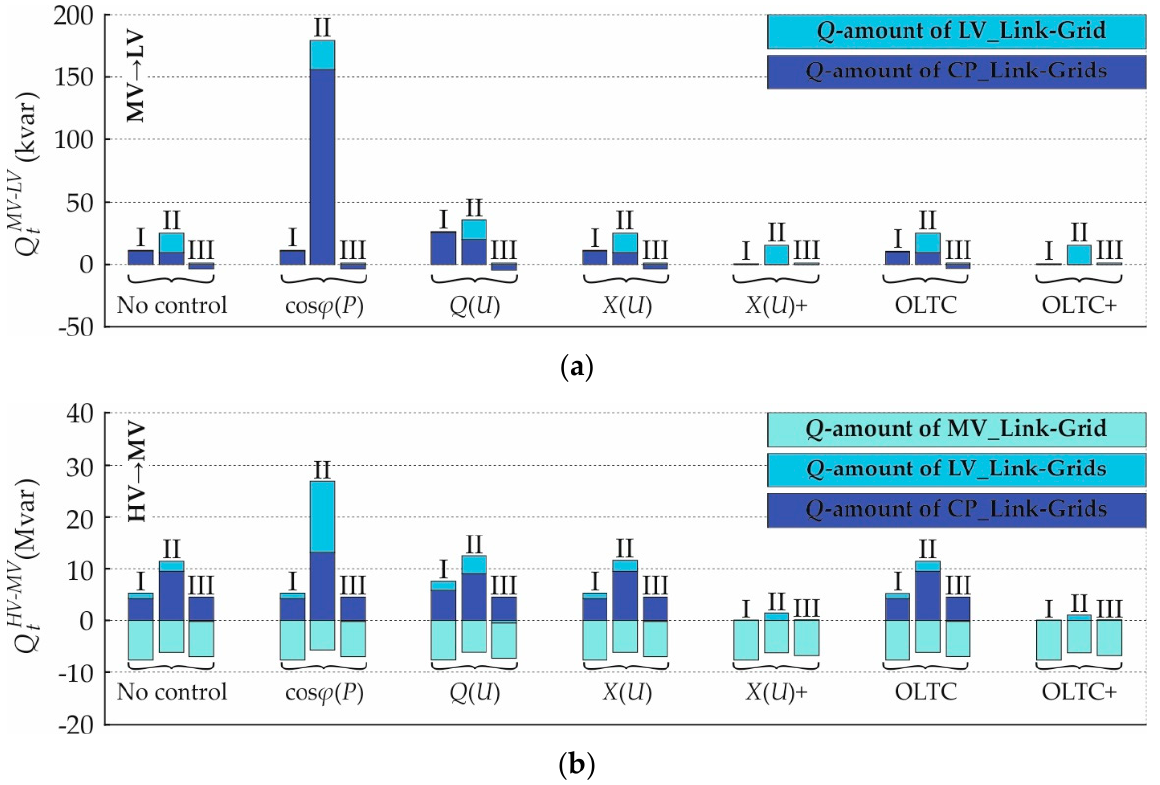
Figure 24. Composition of the reactive power exchange for various control strategies and cases in different system boundaries: ( a ) MV − LV; ( b ) HV − MV.